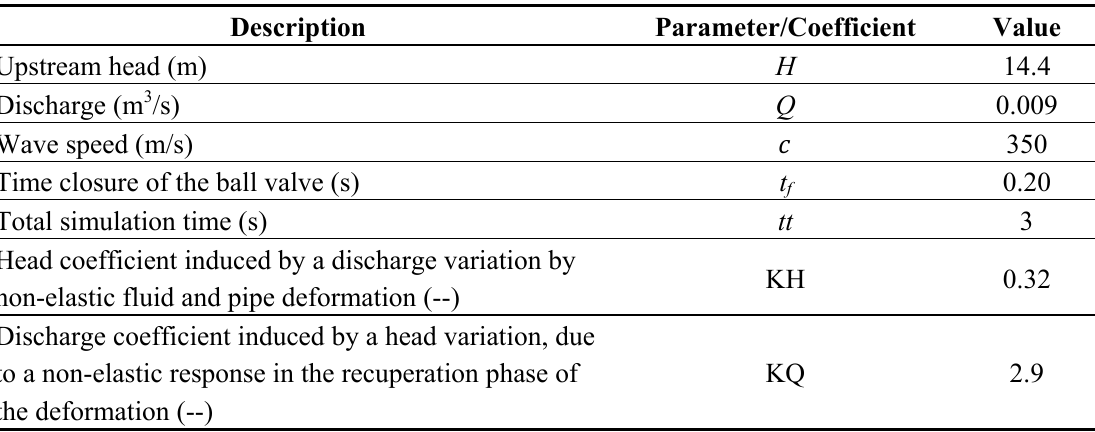
Table 1. Physical characteristics of the laboratory facility and model coefficients.